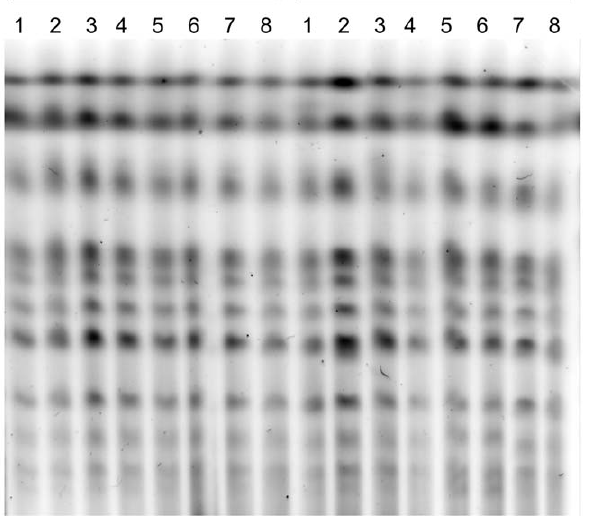
Figure 6. PFGE analysis of chromosomes from 2n ctf18 clones before and after prolonged growth. PFGE analysis of chromo- somes isolated from eight freshly prepared 2n ctf18 clones (numbered 1 to 8) and from the same clones grown for 240 generations. See Materials and Methods for detailes.